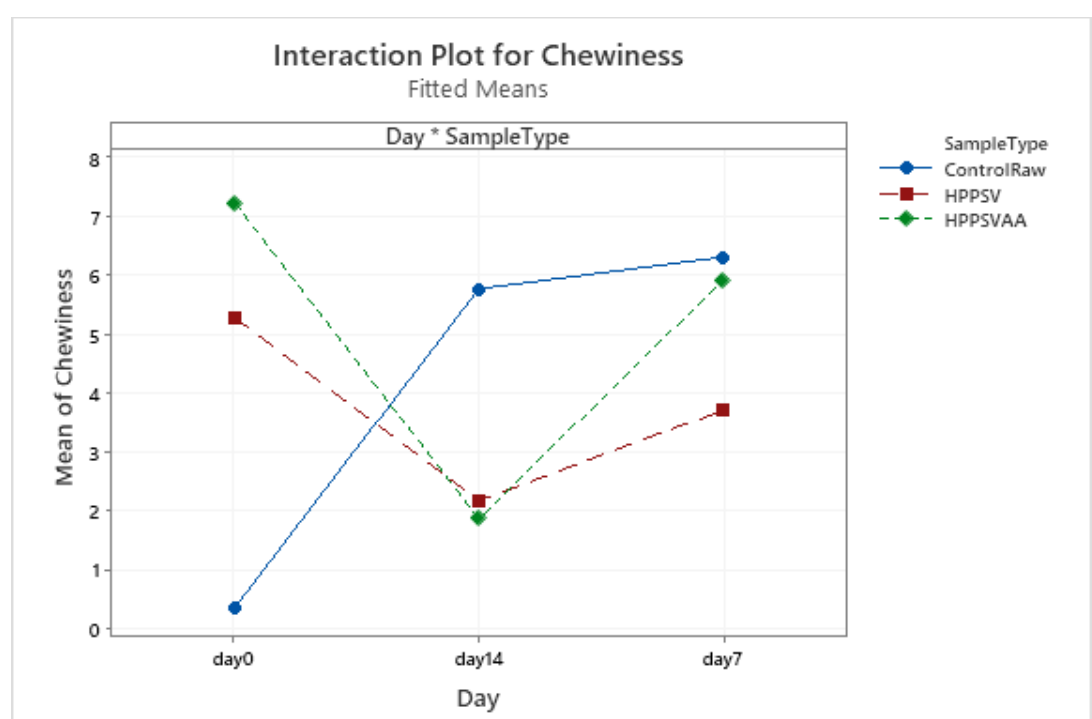
Figure A11. Effect of treatments and storage time on the cohesiveness of hybrid patty (HPPSV: HPP-SVCOOK).